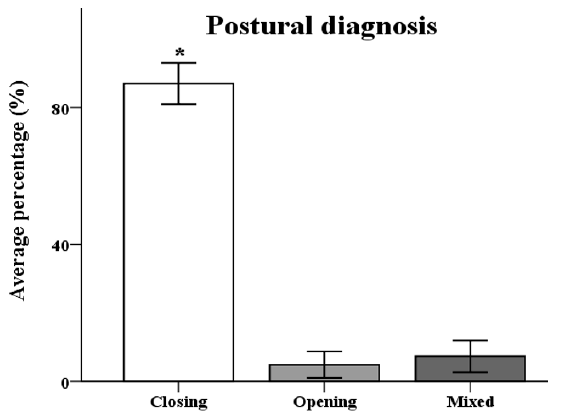
Figure 1. Postural diagnosis of the different morphotypologies. Mean postural diagnosis in the morphologies at closing ( n = 107), opening ( n = 6), and mixed ( n = 9). The closing diagnosis presented a statistically significant difference in relation to the other morphotypologies (* p < 0.0001).